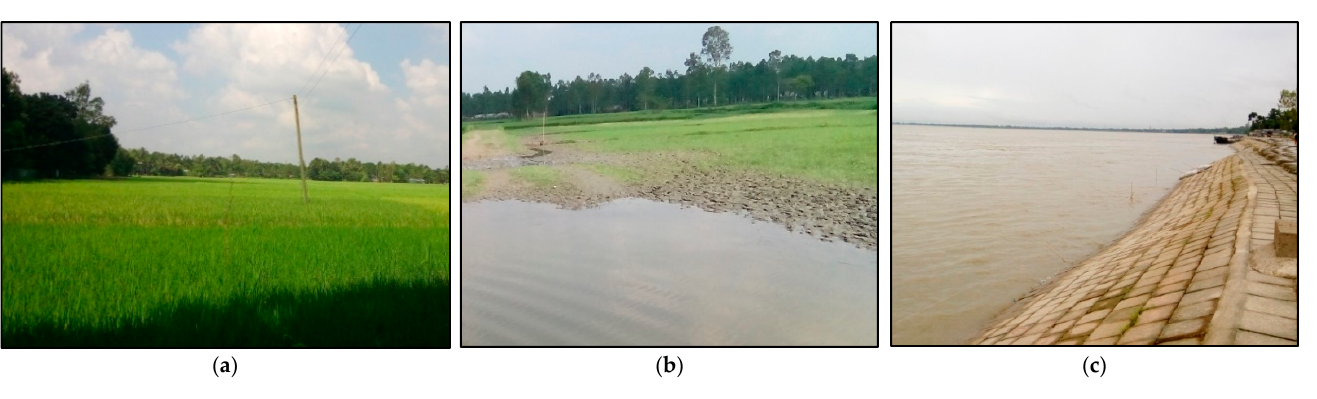
Figure 2. ( a ) Fatepur village; ( b ) Char Fatepur village; ( c ) Kulkandi village (Source: Authors).